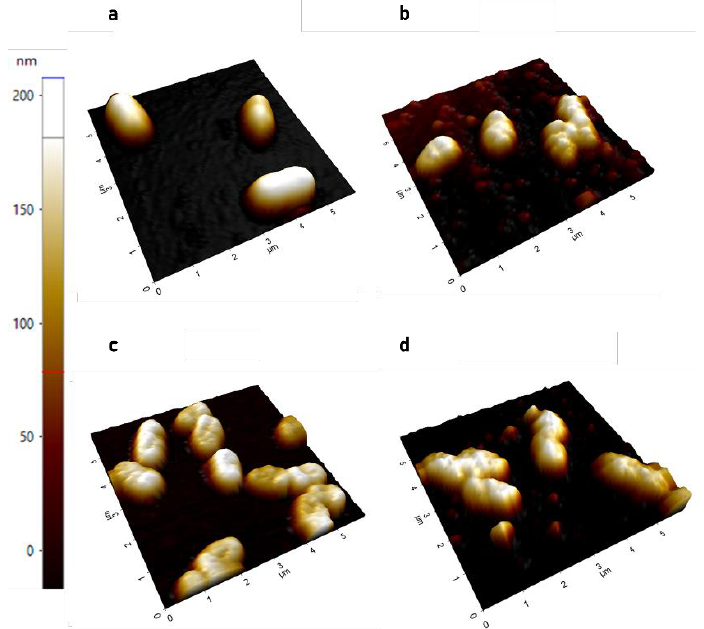
Figure 1. Representative three-dimensional AFM images. ( a ) Bacteria after incubation with solvent control; ( b ) CL-PL-treated bacteria; ( c ) HBD2-treated bacteria; ( d ) CL-PL + HBD2-treated bacteria. Height is depicted in a colored gradient from 0 – 200 nm, illustrated by the scale on the left of the figure. CL concentration was 125 µg/mL, and HBD2 concentration was 0.25 µM.